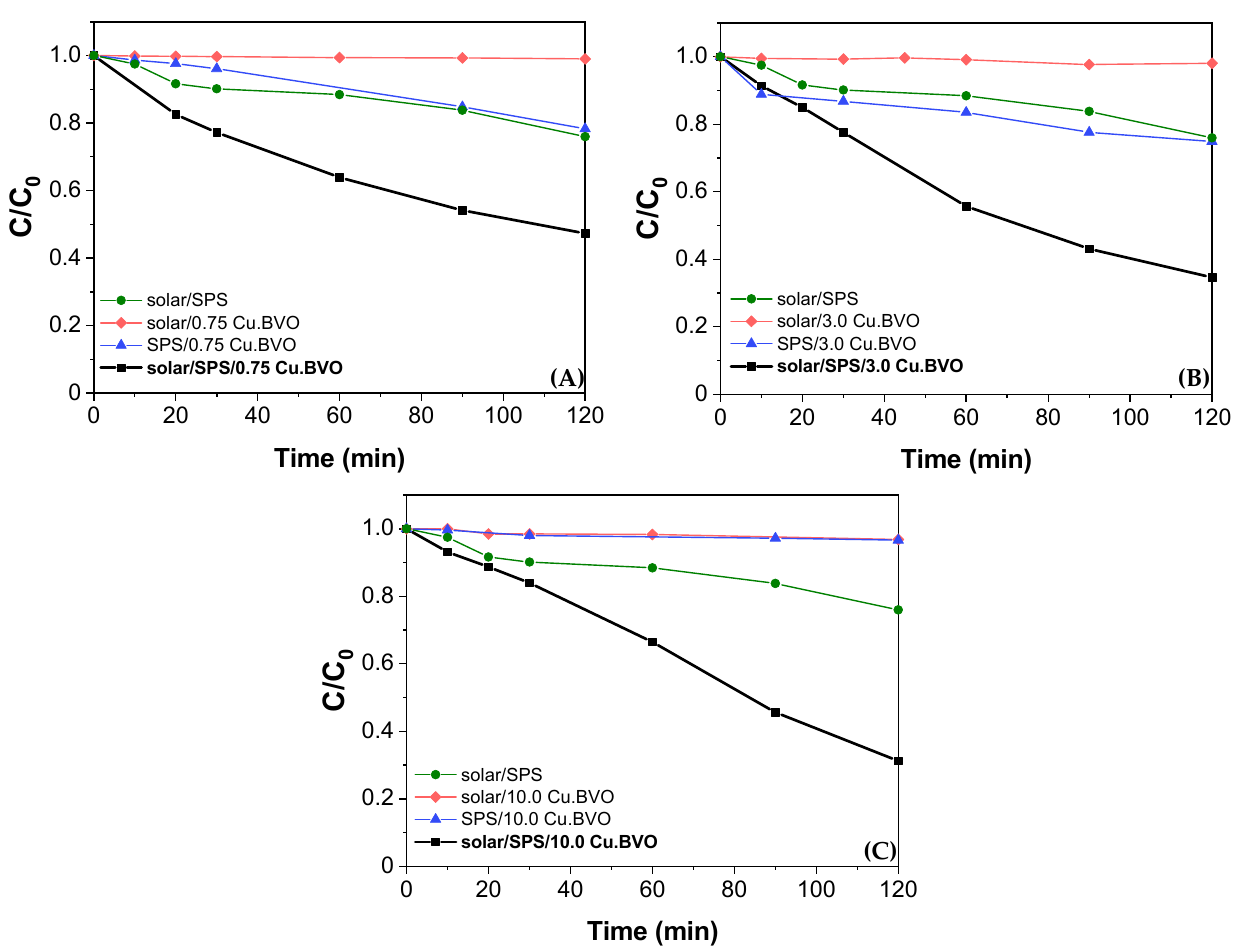
Figure 9. Removal of SMX using solar/SPS, solar/catalyst, SPS/catalyst, and solar/SPS/catalyst for ( A ) 0.75 Cu.BVO, ( B ) 3.0 Cu.BVO and ( C ) 10.0 Cu.BVO in WW. Experimental conditions: 0.5 mg/L SMX, 500 mg/L SPS, 500 mg/L catalyst.